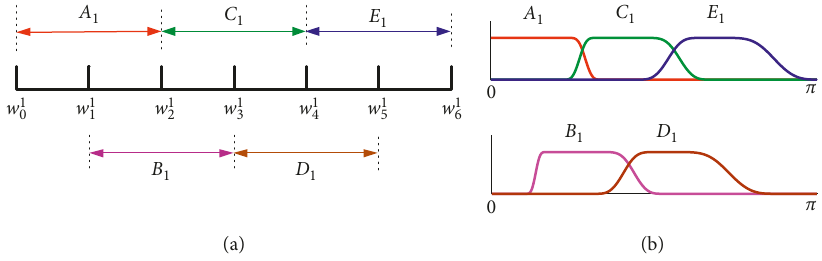
Figure 4: (a)The division of the spectrum when i � 1; (b) two sets of EWT-based filters when i � 1.